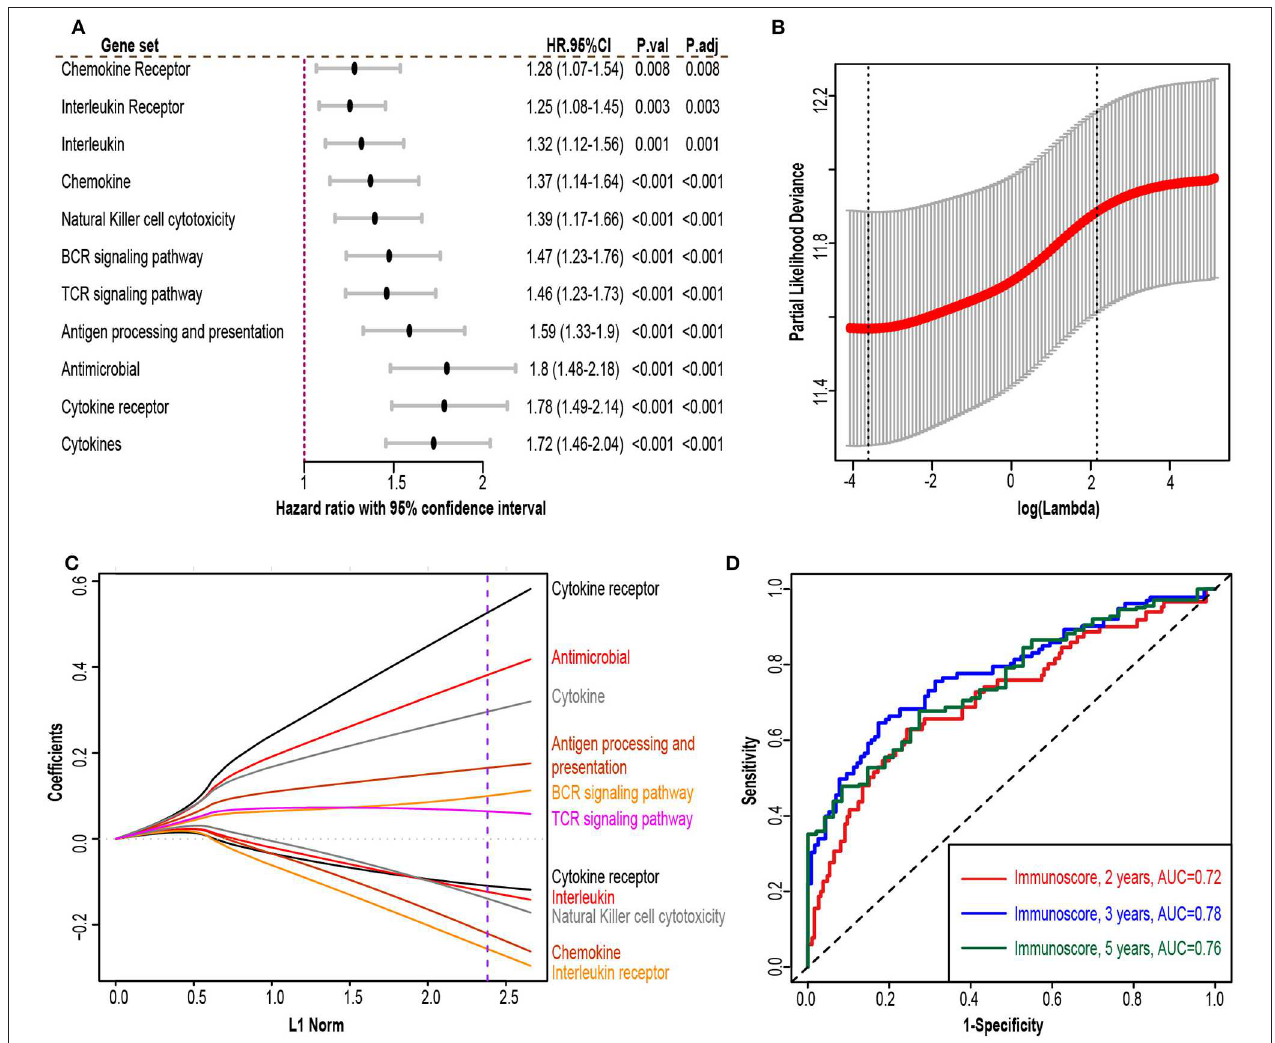
FIGURE 2 | Immunoscore model construction. (A) Forest plot exhibiting different immune gene sets and patient overall survival in the training set. (B) 10-fold cross-validation for tuning parameter selection in the ridge regression model. The partial likelihood deviance is plotted against log ( λ ), where λ is the tuning parameter. Partial likelihood deviance values are shown, with error bars representing standard error (SE). The dotted vertical line on the left was drawn by minimum criteria whereas the line on the right represented the 1-SE criteria. We chose the minimum criteria. (C) Ridge regression coefficients of the 13 immune gene sets. The dotted line indicated the value chosen by the minimum criteria of the 10-fold validation. (D) Time-dependent receiver operator analysis (ROC) of the immunoscore in the training set. HR.95%CI, hazard ratio with 95% confidence interval. P.adj, adjusted P -value by false discovery